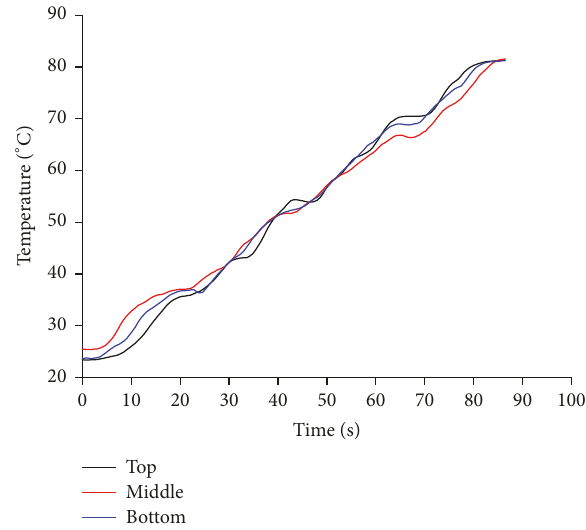
Figure 7: Measured temperature of extraction vial in top, middle, and bottom location (microwave power of 400 W, ethanol concen- tration of 60%, and the ratio of solid to liquid of